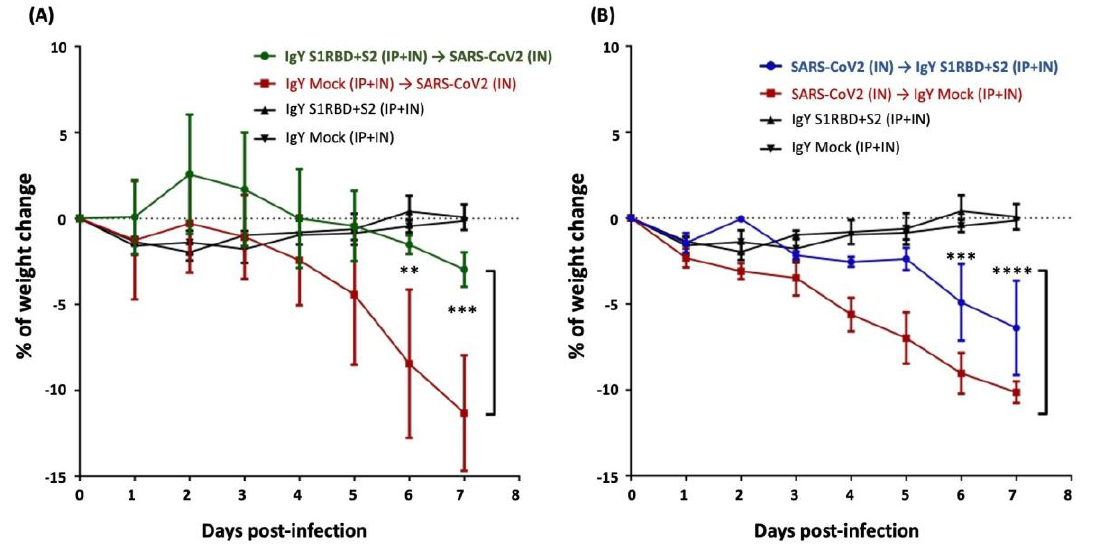
Figure 4. Treatment efficacy of egg yolk IgYs in SARS-CoV-2-infected Syrian hamsters. The efficacy of combination treatment of IgYs specific for S1-RBD and S2 subunits (IgY S1RBD + S2) was examined in Syrian hamsters, and mock IgY was used as the control (IgY Mock). IgYs were simultaneously delivered intranasally and intraperitoneally, either 1.5 h before ( A ) or after ( B ) intranasal delivery of the SARS-CoV-2 Wuhan strain. SARS-CoV-2 infection robustly decreased body weight within 7 days. IgY S1RBD + S2 treatment did not modify body weight in uninfected hamsters. In infected hamsters, administration of IgY S1RBD + S2 before or after infection significantly rescued the weight loss observed in infected hamsters. Data are presented as mean ± SD of three Syrian hamsters from three independent experiments. ** p < 0.01, *** p < 0.001, **** p < 0.0001.